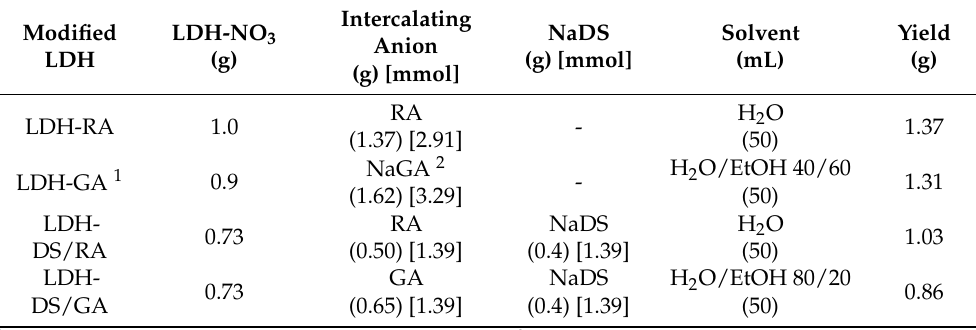
Table 4. Quantities of LDH-NO 3 , rosmarinic acid, mono-sodium salt of glycyrrhetinic acid, and NaDS used for the preparation of modified